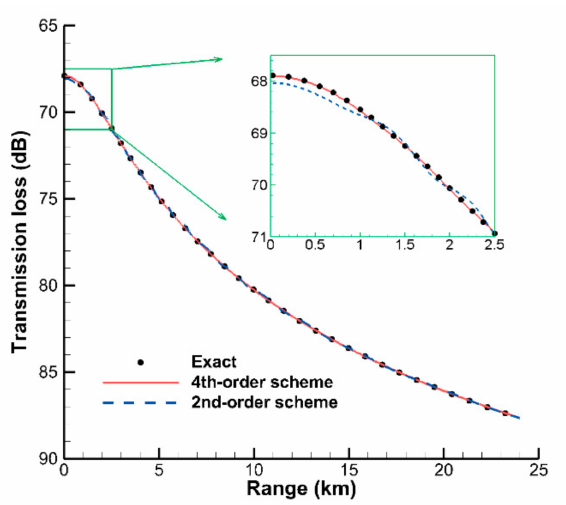
Figure 4. TL curves along z = 20 m for the free acoustic field ( h = 20 m). Figure 5 plots the TL contours and TASI streamlines obtained from the VWI model using the 2nd-order FD scheme (a) and the 4th-order FD scheme (b). In both figures, the TL contour lines are approximately concentric circles (the 4th-order scheme is more accurate than the 2nd-order scheme), whereas the TASI streamlines are straight lines from the source point to infinity, which is consistent with the characteristics of spherical waves in free